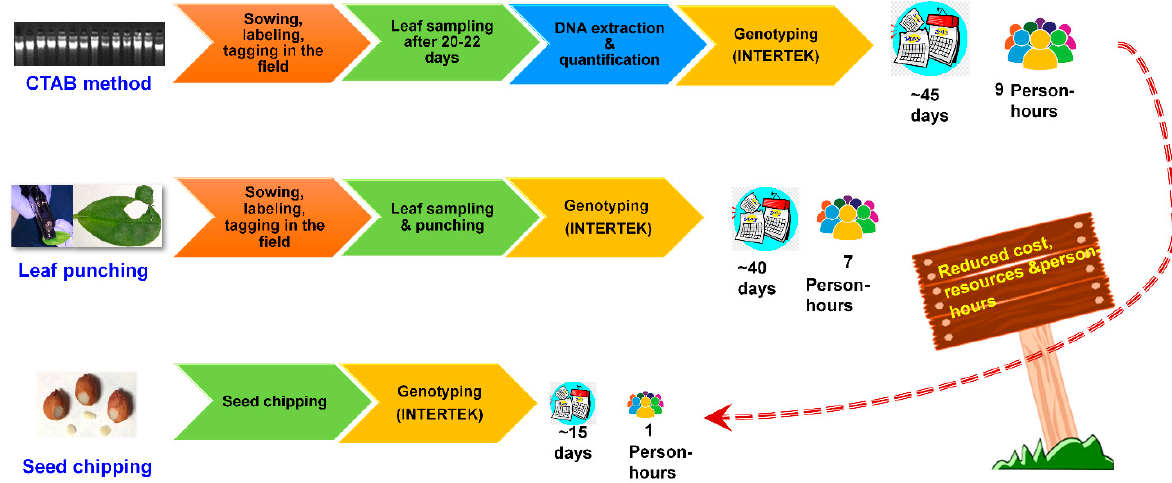
Figure 5. Comparative assessment for cost-effectiveness and time saving among DNA-based, leaf-punching, and single seed-chipping based genotyping.